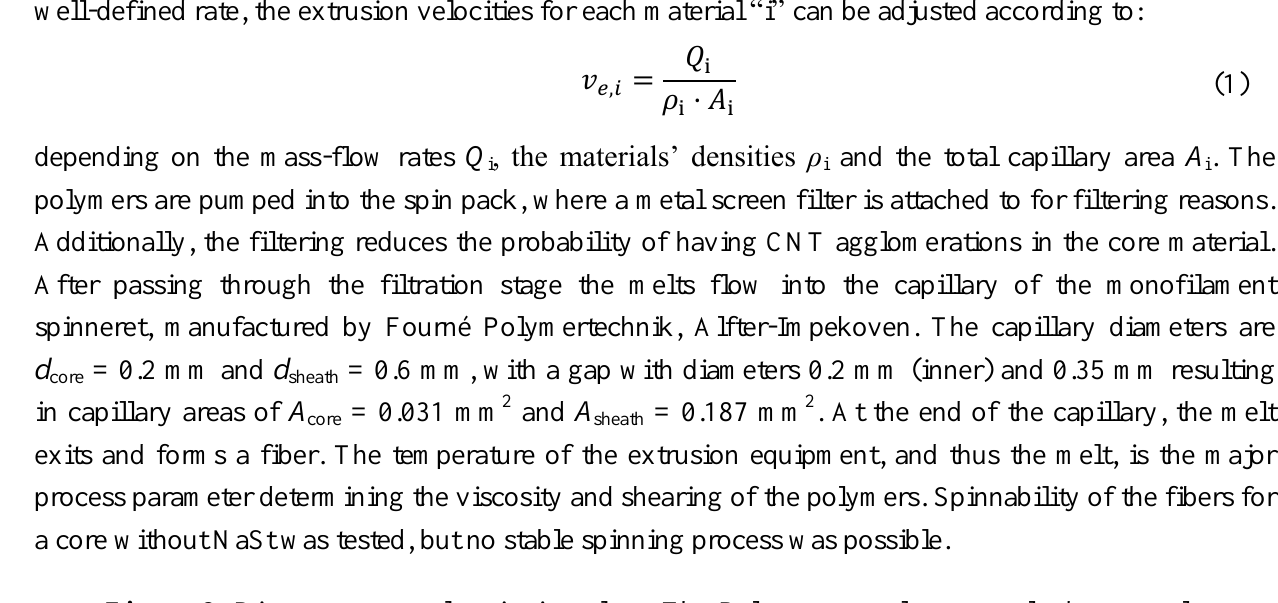
Figure 2. Bicomponent melt spinning plant. The Polymer granules are melted separately (1–3) and combined to a core/sheath structure in the spinneret